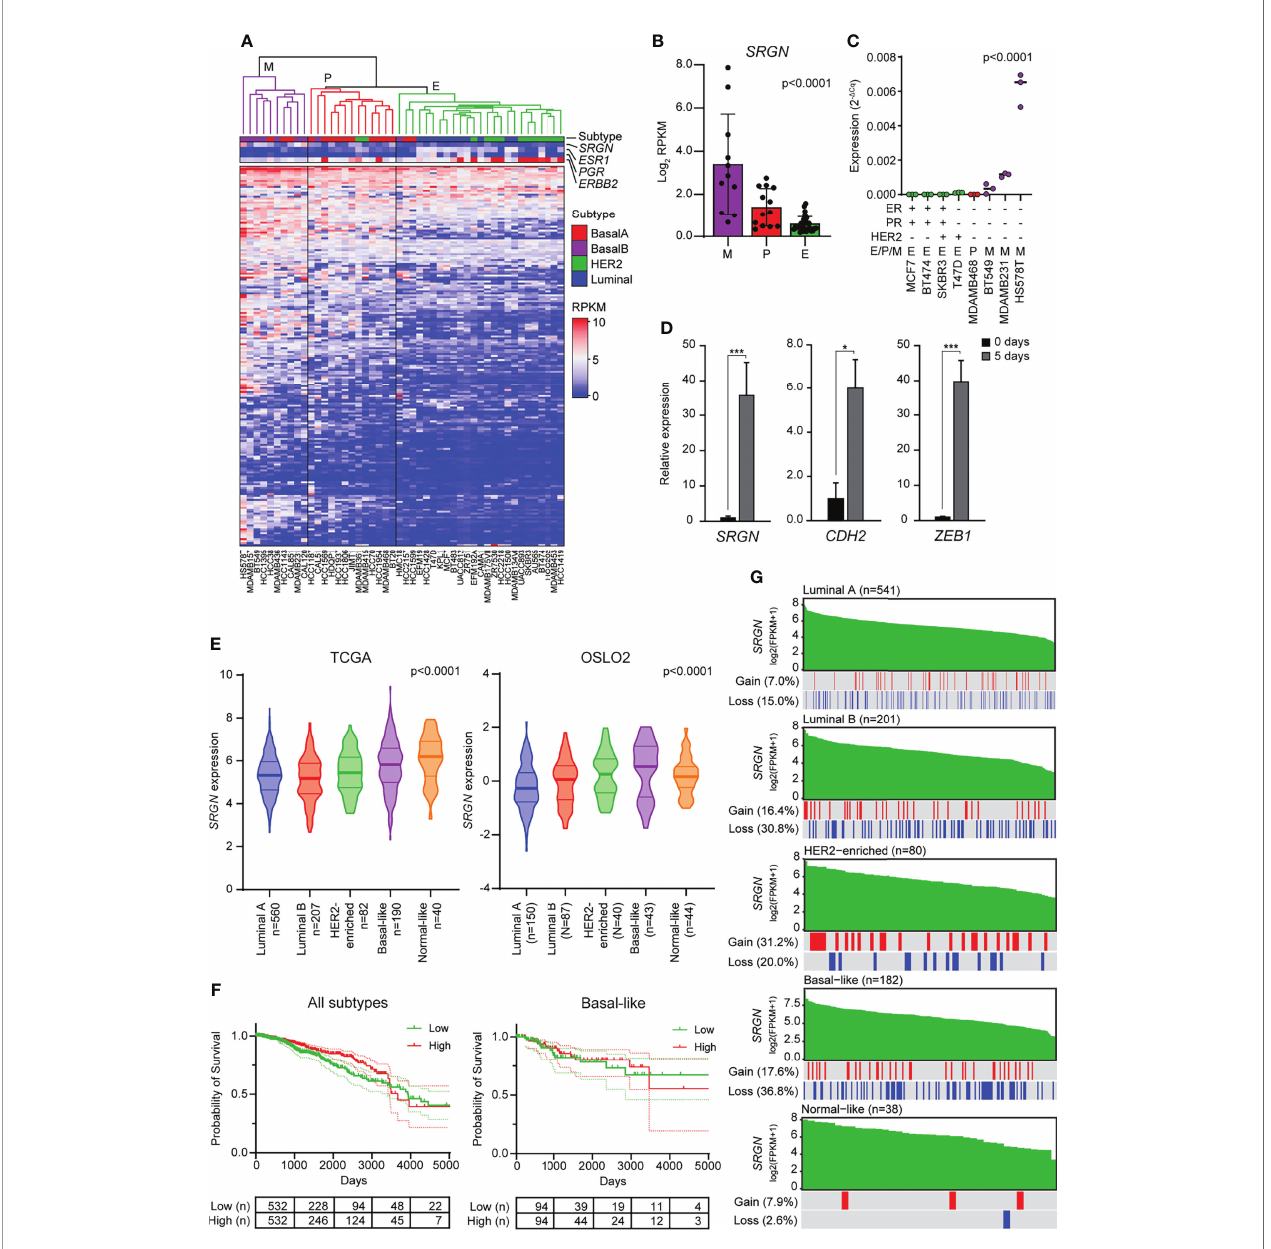
FIGURE 3 | Breast cancer cell lines with a mesenchymal phenotype and the basal-like subtype of breast cancer express high levels of serglycin. (A) Hierarchical clustering of 48 breast cancer cell lines based on 194 genes included in the EMT hallmark gene dataset. Subtype and expression of SRGN , ESR1 , PGR , and ERBB2 are shown separately above the heatmap. E, epithelial; P, partial EMT; M, mesenchymal; RPKM, reads per kilobase per million. (B) SRGN expression in cell lines de fi ned as epithelial (E) , partial EMT (P), or mesenchymal (M) based on hierarchical clustering. (C) SRGN expression in breast cancer cell lines evaluated by RT-qPCR. E, epithelial; P, partial EMT; M, mesenchymal. (D) SK-BR-3 cells were stimulated with 20 ng/ml EGF for 5 days. SRGN , CDH2 , and ZEB1 expression were evaluated by RT-qPCR. The experiment includes three biological replicates and is representative for one of a minimum of three independent experimental setups. Error bars represent standard deviation. (E) SRGN expression in the TCGA and OSLO2 cohorts. (F) Probability of survival for either all breast cancer patients or only patient with the basal-like subtype from the TCGA cohort. High and low expression is based on the median expression value of SRGN . Dotted lines represent the 95% con fi dence interval (G) Serglycin copy number gain or loss for patients included in the TCGA cohort. Green bars represent SRGN expression, arranged from high to low expression within each subtype. A red line indicates a copy number gain while a blue line represents a copy number loss in the patient with the speci fi c expression value bar seen above in green. FPKM, fragments per kilobase per million. (***p ≤ 0.001; *p, ≤